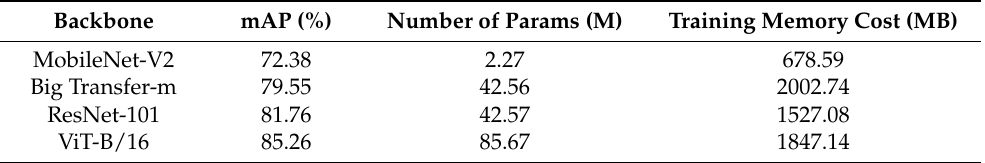
Table 3. Experimental results of the four feature extraction networks.